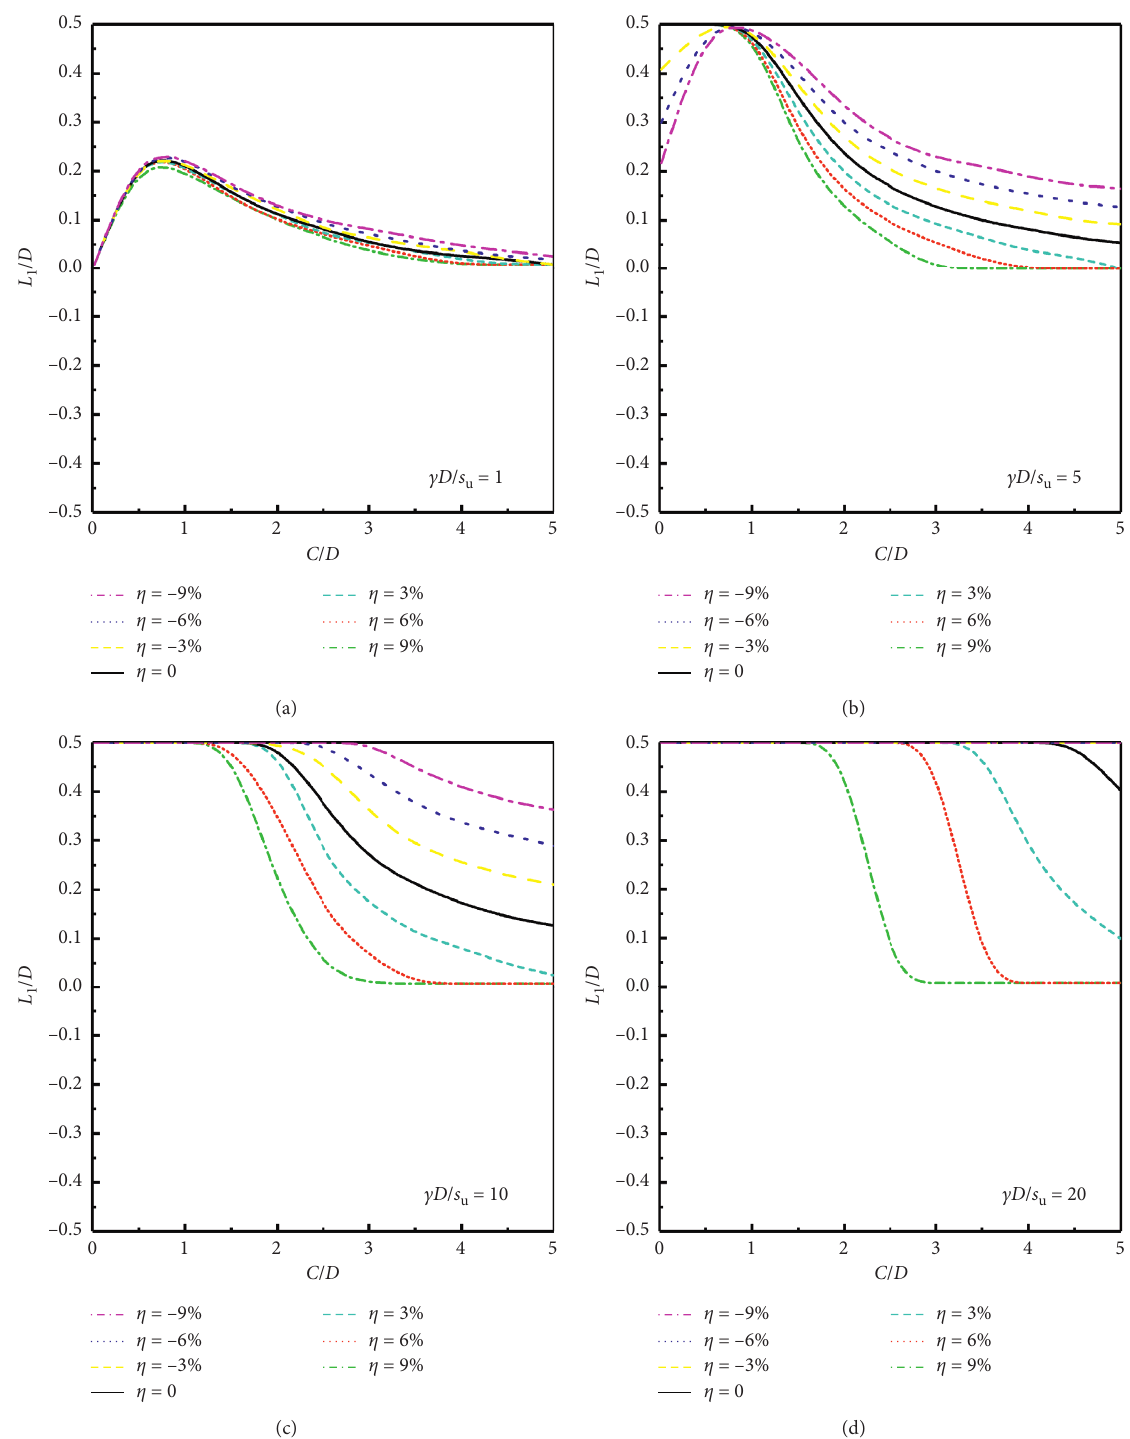
Figure 4: Influence of the parameter L 1 / D on the stability number N for